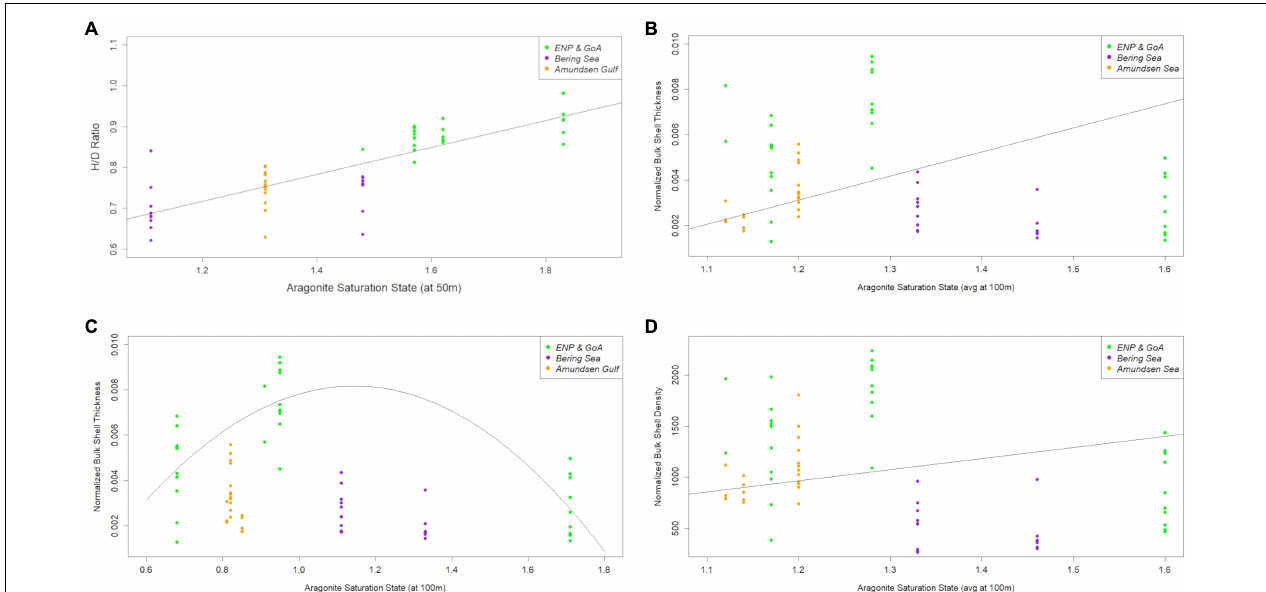
FIGURE 10 | Height-diameter (H/D) ratio distribution (A) , normalized bulk shell thickness with linear fit (B) , normalized bulk shell thickness with polynomial fit (C) , and normalized bulk shell density (D) along the omega saturation state ( ar ) in three basins (based on the observational data) in Limacina helicina pacifica. The equations for correlation with omega saturation state ( (cid:127) ar ) or the combination of temperature and (cid:127) ar are following: Shell morphology (H/D; Figure 10A ) = 0.32095 + 0.33014* (cid:127) ar ; Normalized Shell Thickness (linear; Figure 10B ) = 0.001459 + 0.001895* (cid:127) ar ; Normalized Shell Thickness (polynomial, Figure 10C ) = 0.005569 − 0.0010466* (cid:127) ar − 0.0004721* (cid:127) 2 (cid:127) ar )) = 6.803*10 − 3 − 3.984*10 − 5 *T-2.364*10 − 3 * (cid:127) ar ; Normalized Shell Density ( Figure 10D ) = ar ; Normalized Shell Thickness (f (T and − 182.5 + 294.3* T − 234.9* (cid:127) ar